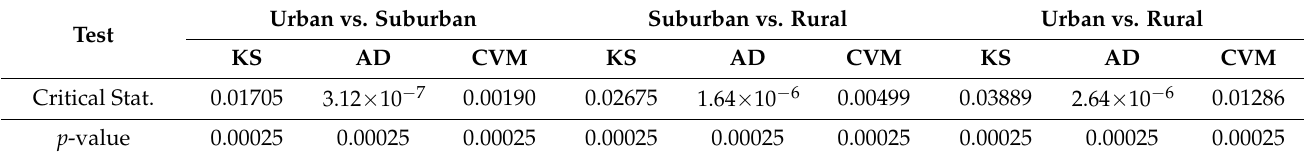
Table 8. Results of the two-sample goodness-of-fit tests (nationwide). Urban vs. Suburban Suburban vs. Rural Urban vs. Test